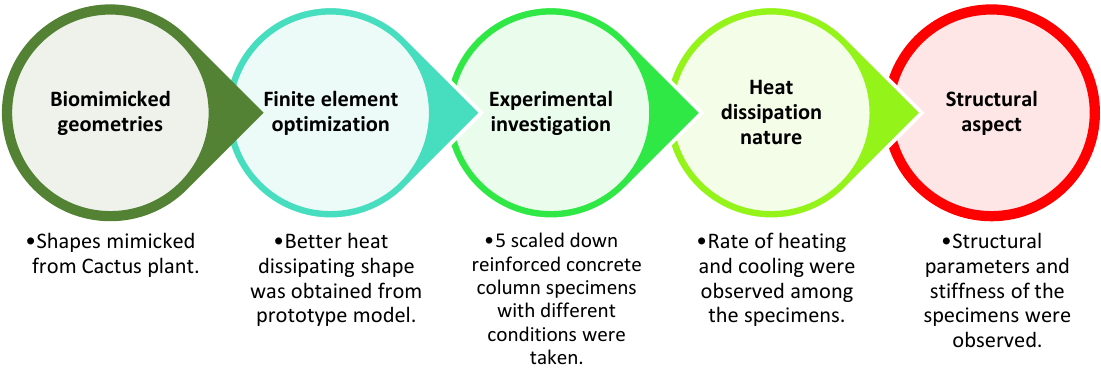
Figure 3. Methodology of the study. Few sharp pointed shapes were taken into account based on the Saguaro Cactus [44]. The shape was optimized using finite element analysis through a prototype model. The visual comparison of a Saguaro Cactus and the proposed mimicked shape is represented in Figure 4. The various shapes adopted for the optimization are represented in Figure 5.